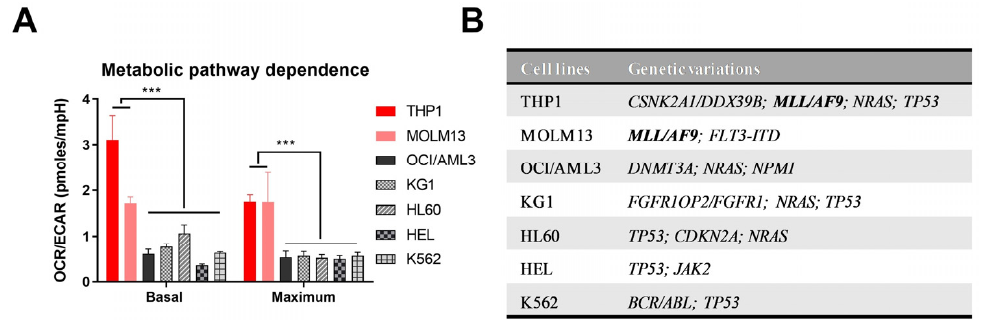
Figure 1. Metabolic pathway dependence of human AML cell lines. ( A ) Mitochondrial respiration and glycolysis were determined in various AML cell lines by Seahorse XFe96 Extracellular Flux Analyzer. Basal and maximum oxygen consumption rate (OCR) and extracellular acidification rate (ECAR) were measured, and metabolic pathway dependence was obtained as the percent ratio of OCR and ECAR. Results are expressed as mean ± standard deviation, n = 3. ( B ) AML cell lines used in the experiment and their major genetic variations. Bold letters are a common mutation of THP1 and MOLM13. (*** p < 0.001)